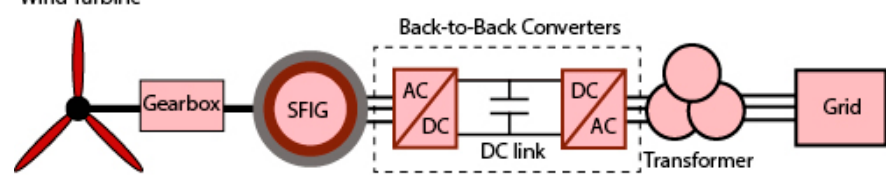
Figure 4. Squirrel cage induction generator.